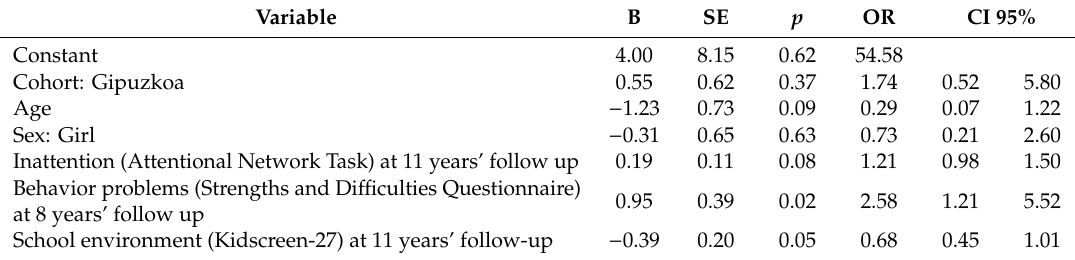
Table 6. Predictors of being a bully-victim for the whole